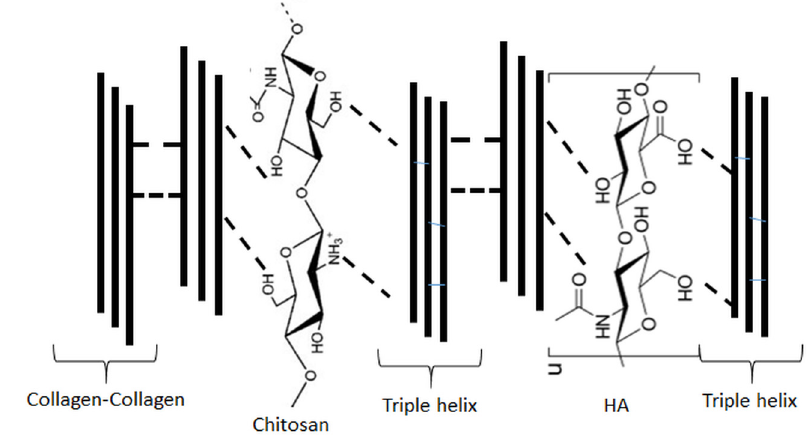
Figure 5. Possible interactions between collagen, chitosan, and hyaluronic acid in blends.